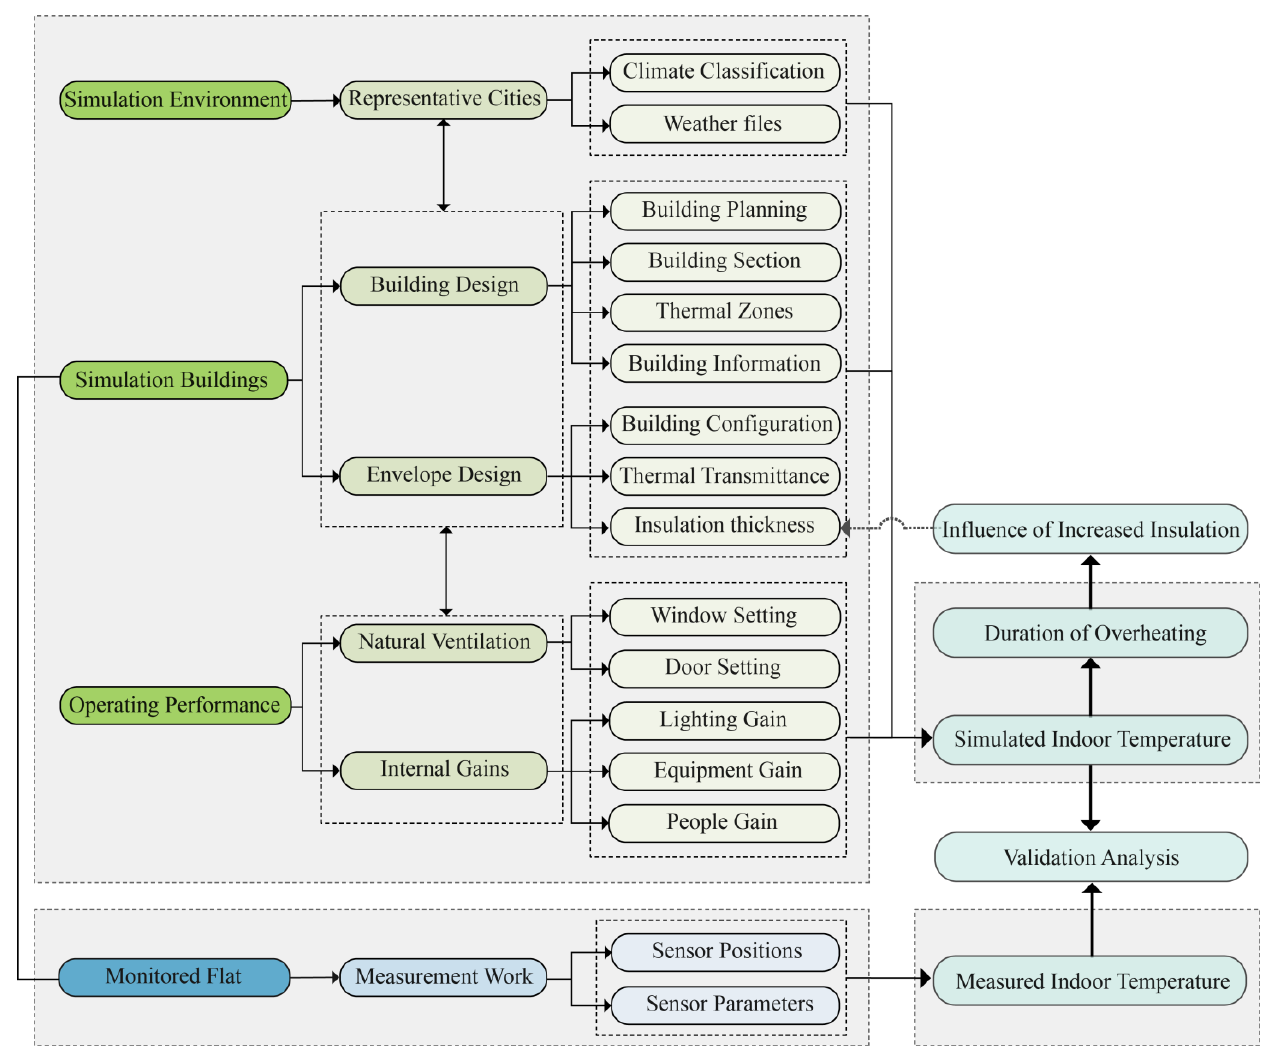
Figure 1. Framework of the study.